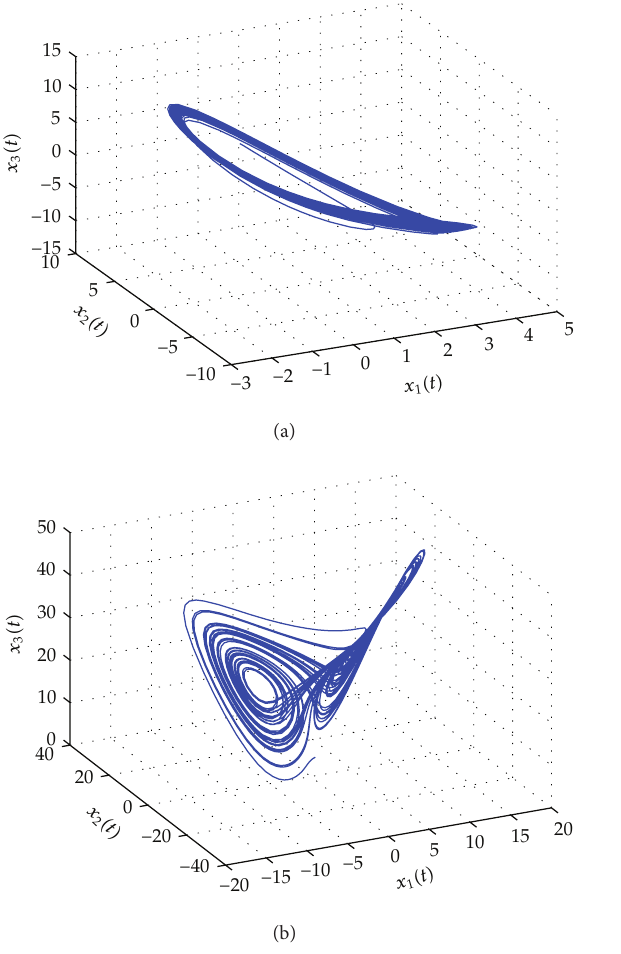
Figure2:(a)Chaoticbehaviorofthemastersystem(51).(b)Chaotic behavior of the slave system (52) without control.